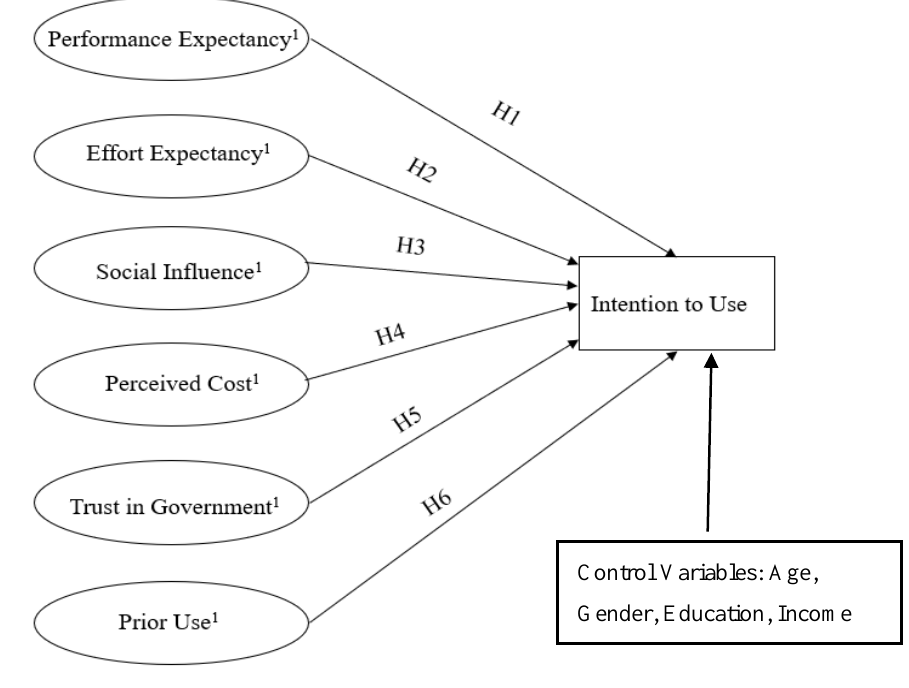
Figure 1. Proposed model. 1 After controlling for demographic factors.